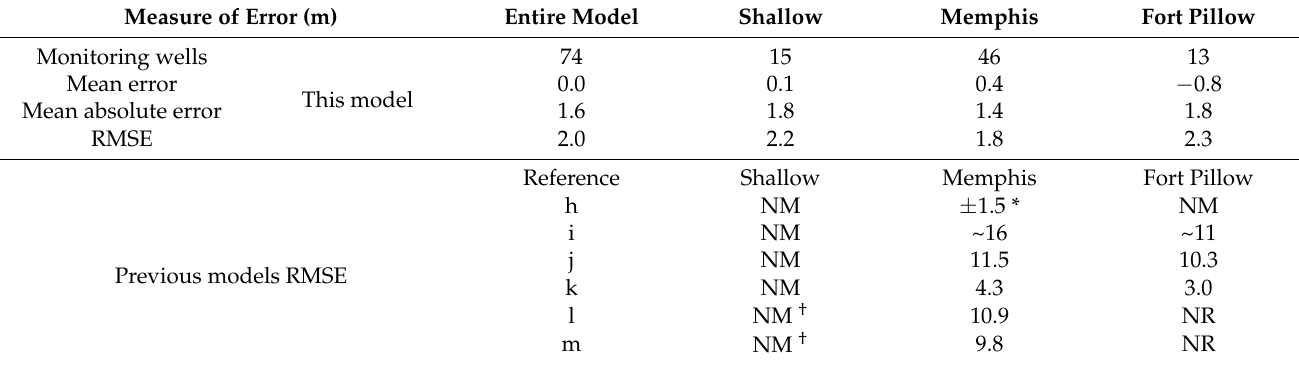
Table 4. Average measure of error for each aquifer in this study and previous